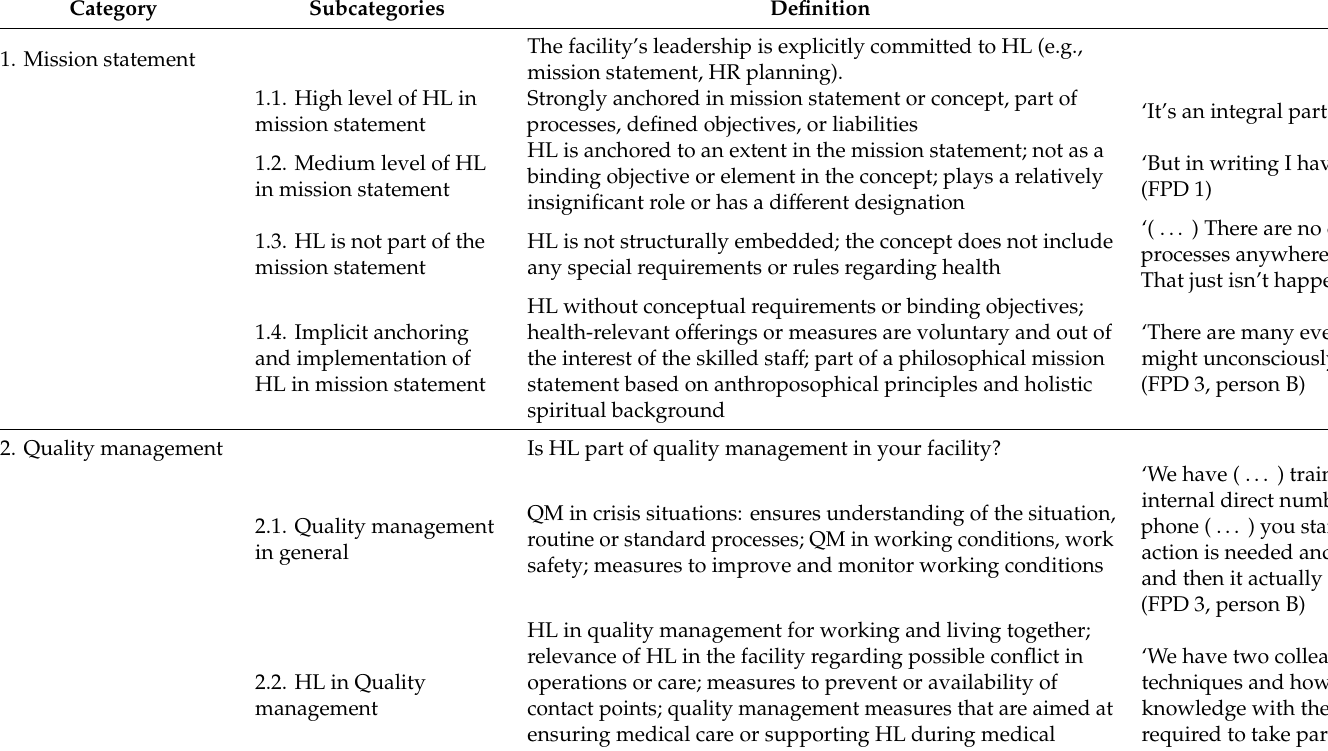
Table A1. Detailed codebook for qualitative content analysis with anchor examples (according to Kowalski et al. 2015 and based on HLHO-10 questionnaire).